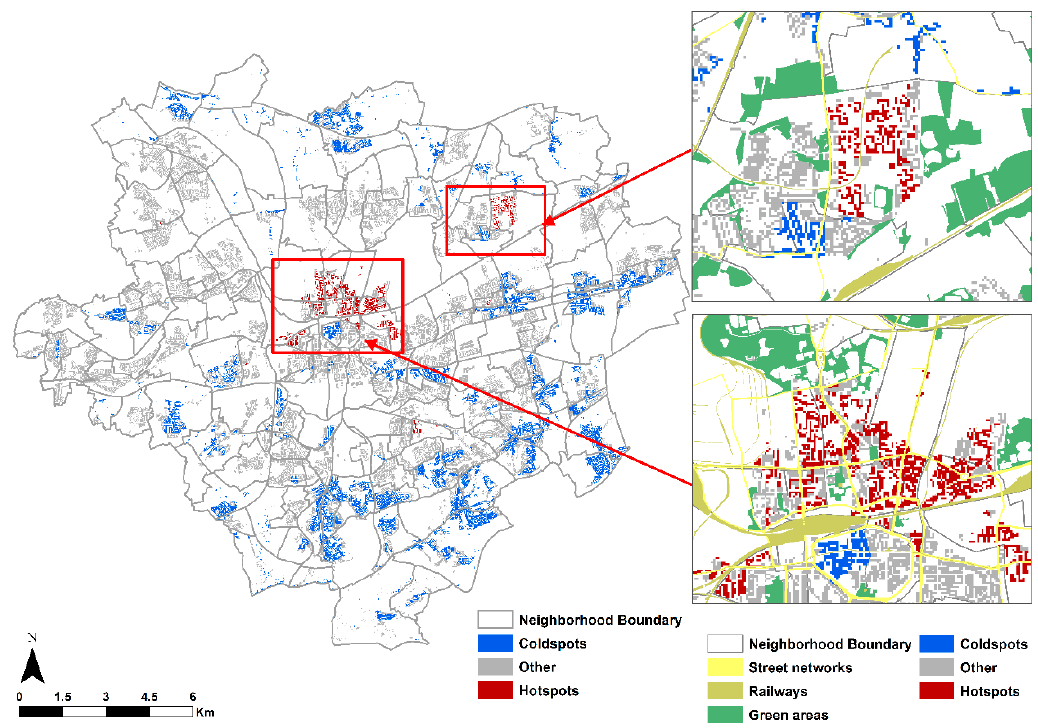
Figure 4. Spatial distribution of “hotspots” and “coldspots” of integrated index of multiple environmental burdens and benefits with social vulnerability.